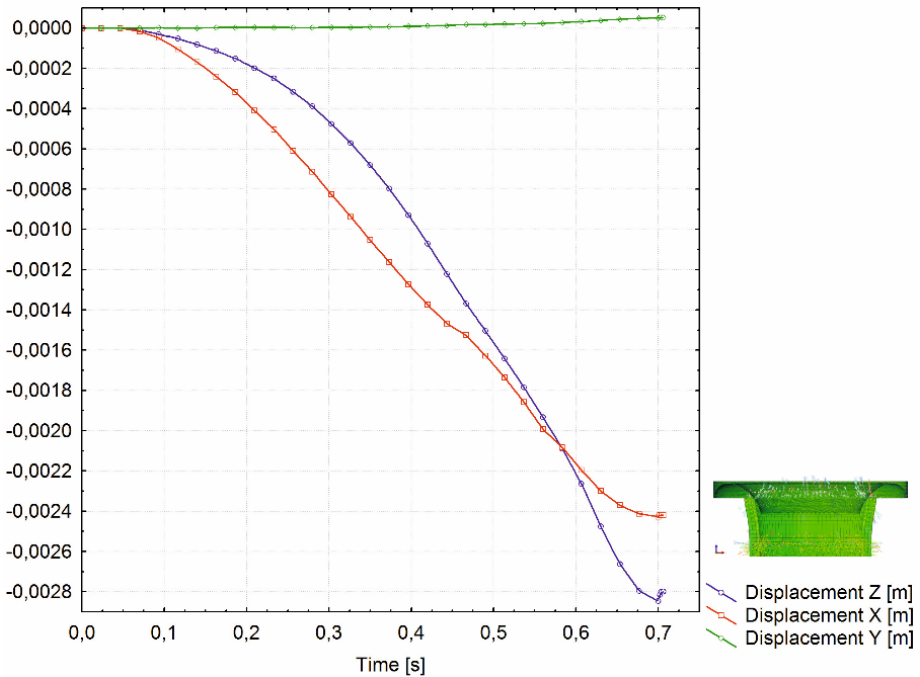
Figure 8. Spatial displacement of node on OD of rivet during process XZ plane.